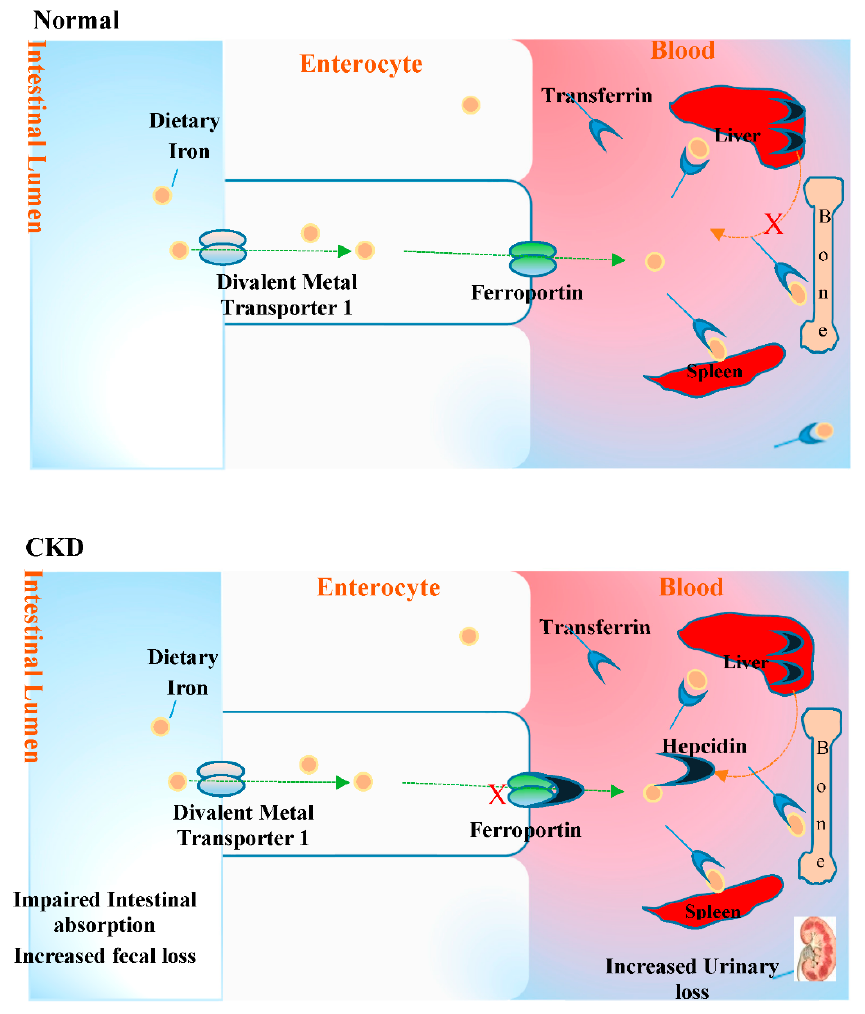
Figure 4. Mechanism of iron deficiency anaemia (IDA) in CKD. Normally, liver hepcidin synthesis is inhibited, allowing the uptake of dietary iron to replace the average 1–2 mg daily iron loss in adults via divalent metal transporter 1 (DMT1) at the apical brush border of enterocytes. Ferric reductase reduces the predominant Fe 3+ to Fe 2+ prior to DMT1 transport. Intracellular iron is stored as ferritin in the enterocytes while basolateral iron is transported by ferroportin into the circulation, where iron Fe 3+ (generated by oxidation of Fe 2+ by ferroxidases such as hephaestin) is loaded onto transferrin to be transported to storage (e.g., liver) or utilization site (bone marrow). In CKD, the presence of chronic inflammation with elevated cytokines such as IL-6 levels results in increased hepcidin secretion. Consequently, the binding of hepcidin to the iron transporter ferroportin induces its endocytosis and proteolytic destruction, thus preventing the transport of dietary iron into the circulation. Hepcidin secretion prevents the release of iron from storage sites [62]. Additionally, the apparent loss of iron via urine which is associated with kidney dysfunction may exacerbate IDA and reduce the efficacy of IV iron in the late stages of CKD.